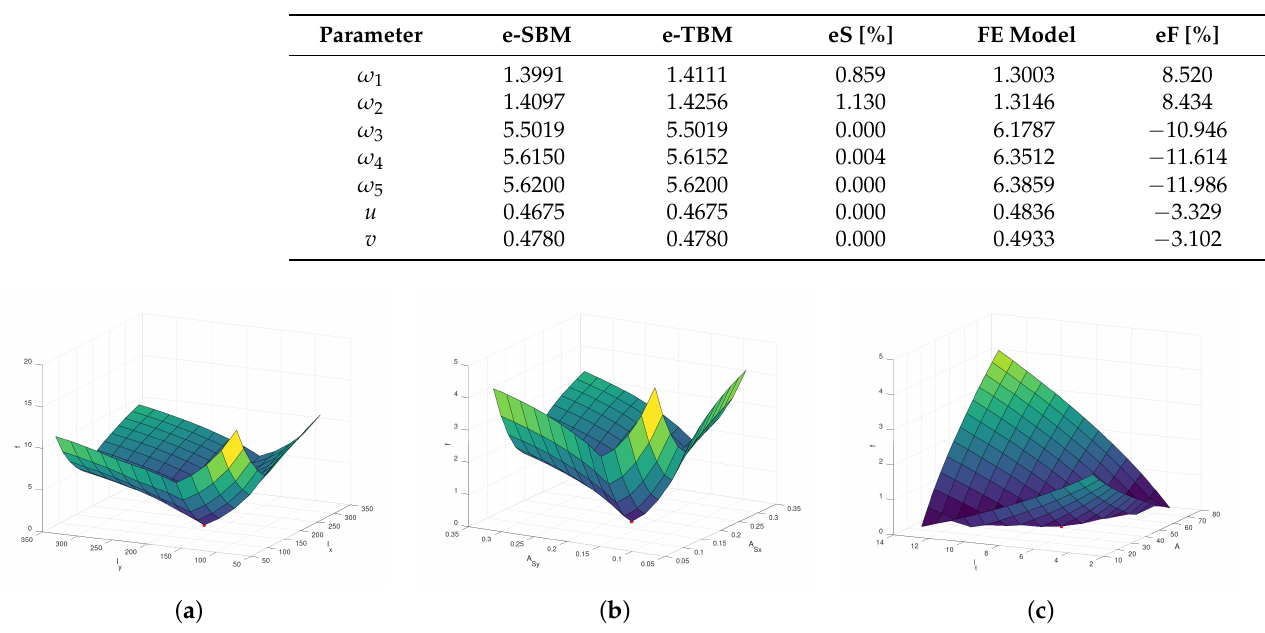
Table 4. Natural frequencies of the three models and relative errors: between e-TBM and e-SBM (eS); between e-TBM and FE model (eF).